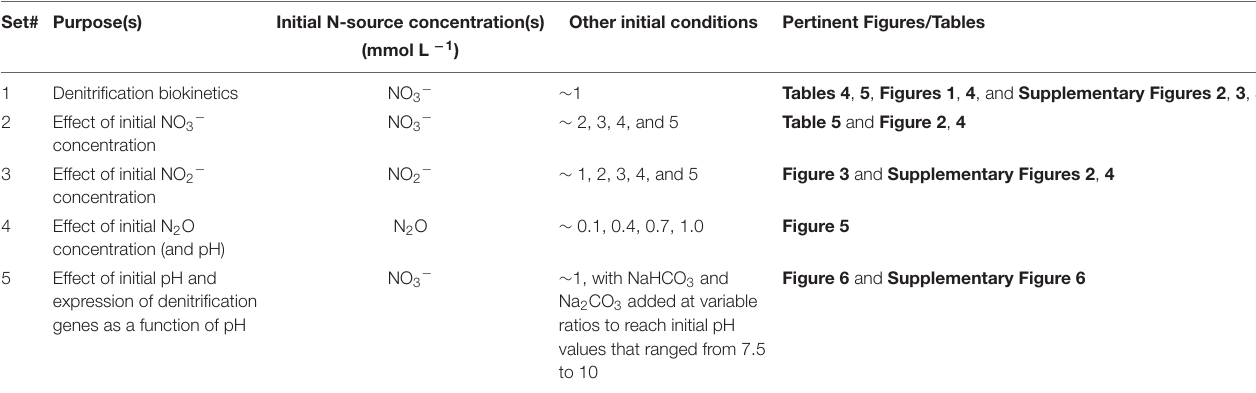
TABLE 2 | Description of sets of microcosm batch tests conducted, including their purpose, the initial N-source (NO 3 − , NO 2 − or N 2 O) and their concentrations, other initial conditions, and the figures and/or tables where the results are